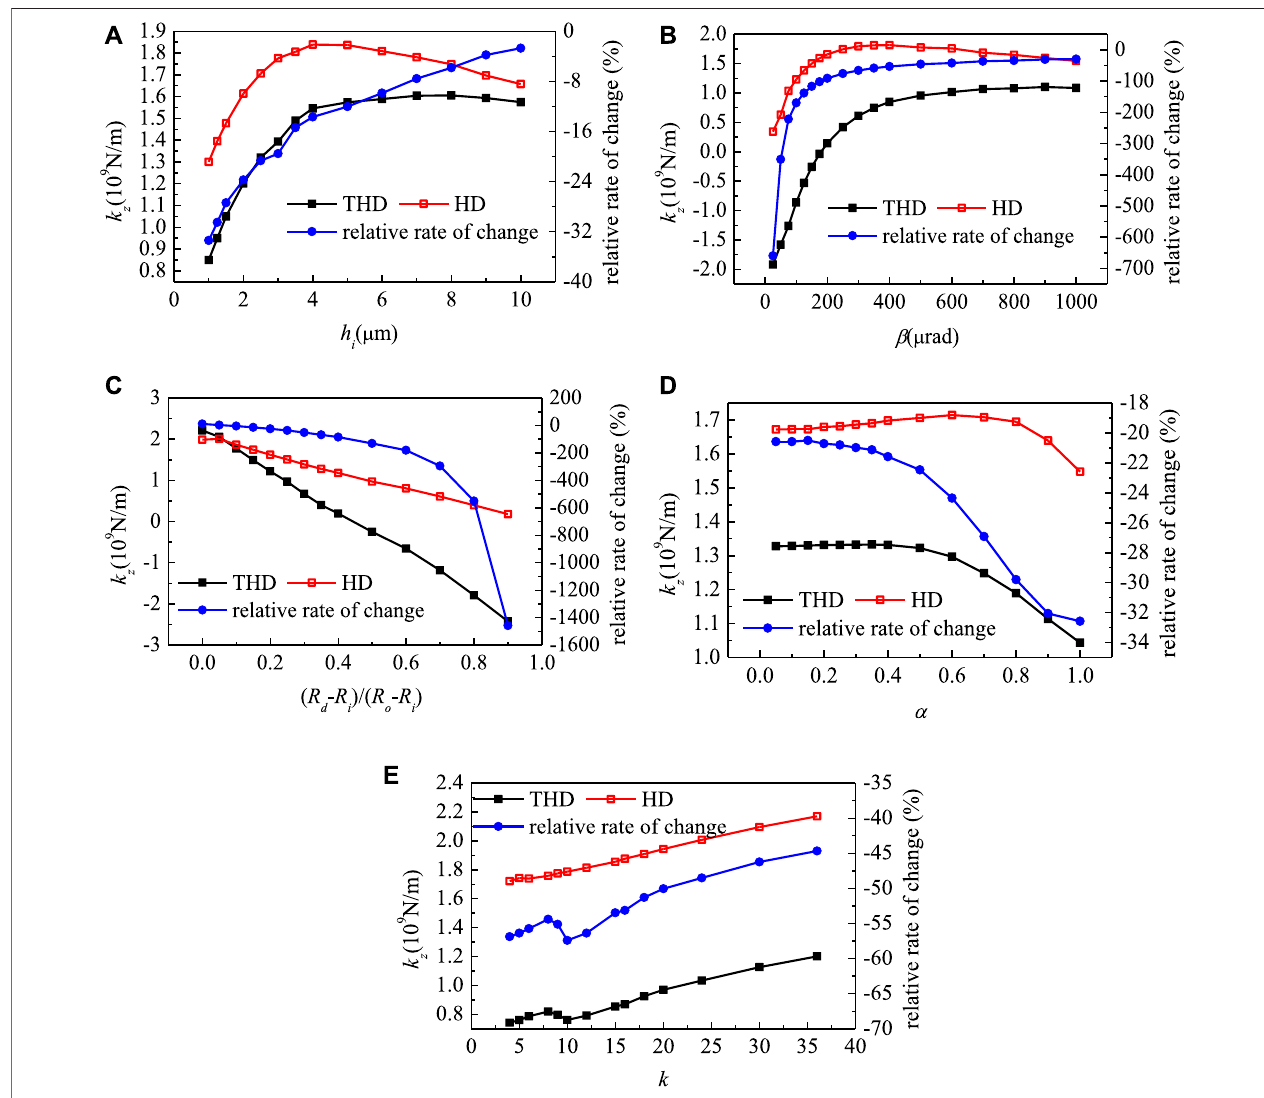
FIGURE 6 | Effect of structural parameters on the fl uid fi lm stiffness under the viscosity-temperature effect.